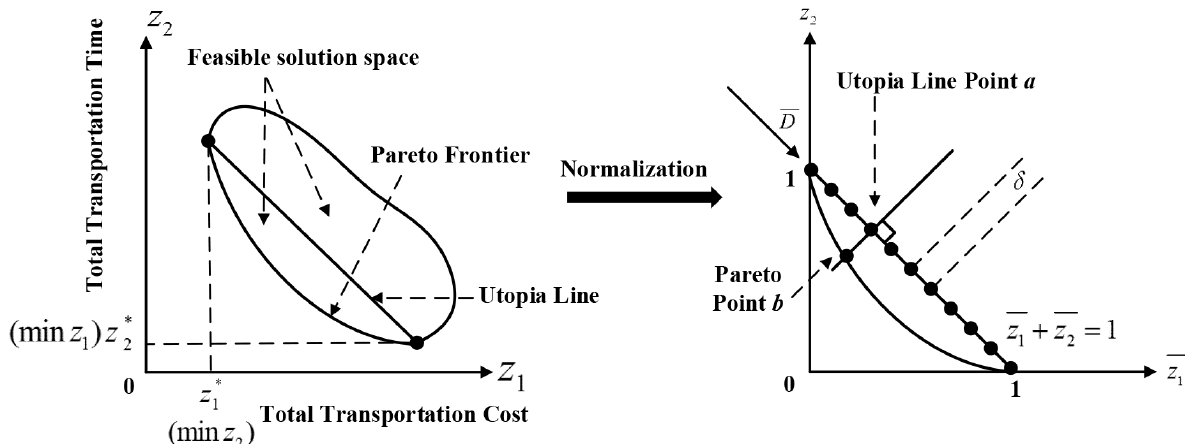
Figure 1. Normalized normal constraint